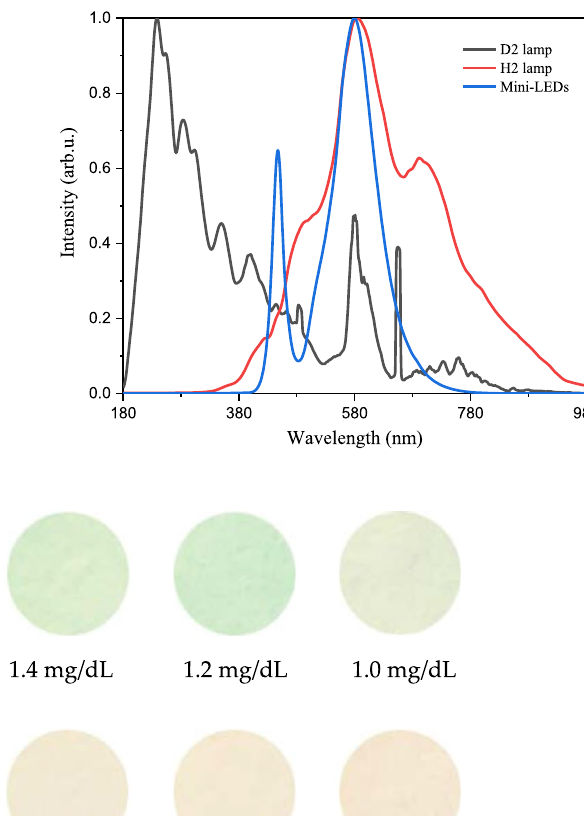
Fig. 5 Emission spectra of D2 lamp, H2 lamp, and Mini-LEDs